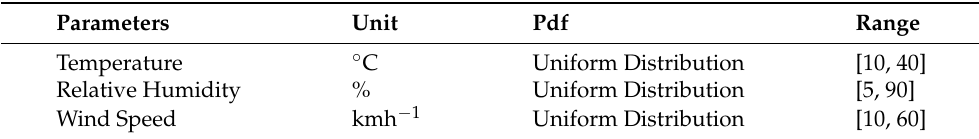
Table 2. Range and Probability Density Function (PDF) of three input parameters—temperature, relative humidity, and wind speed. The ranges and the distributions of the input parameters are chosen to cover operational weather conditions for wildfire modeling in the Australian scenario as per the experimental setup of our previous